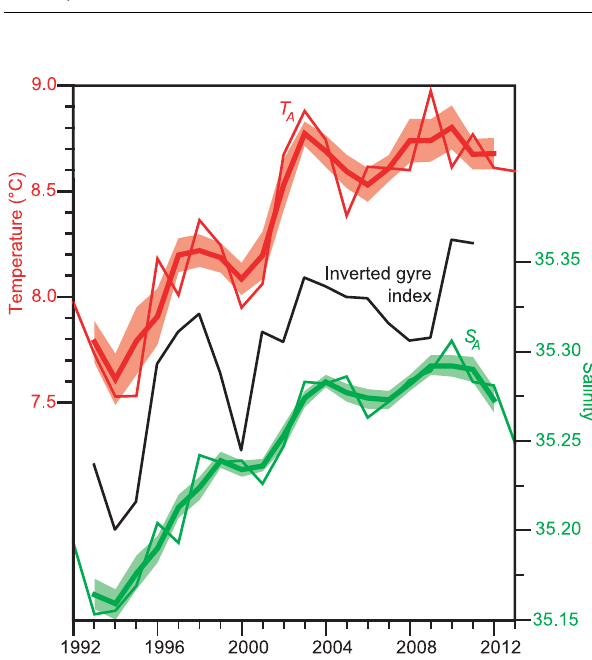
Figure 7. Interannual variation of Atlantic water temperature, T A (red) and salinity, S A (green) and of the inverted subpolar gyre in- dex (black). For T A and S A , the figure shows annually averaged deseasoned values (thin curves) and 3-year running mean of desea- soned values (thick curves) with background colors indicating ± one standard error over each 3-year period. The inverted (for easier comparison) gyre index (updated from Larsen et al., 2012) is shown in a relative scale.